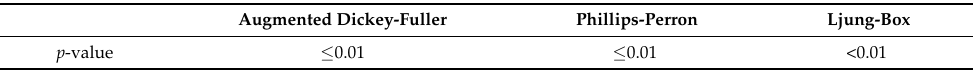
Table 6. Summary of the obtained p -values when applying, to each of the 62 buoys, three different tests to check for stationarity. Each of the 62 p -values is smaller or equal than 0.01 for the Augmented Dickey–Fuller test (first column) and the Phillips–Perron test (second column). Each of them is smaller than 0.01 for the Ljung–Box test (third column). The null hypothesis is of non-stationarity. Augmented Dickey-Fuller Phillips-Perron Ljung-Box